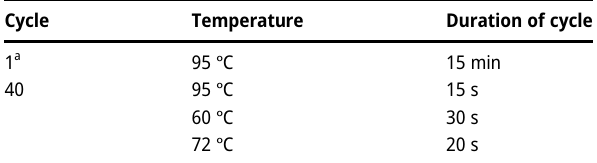
Table  : Three-step PCR program.